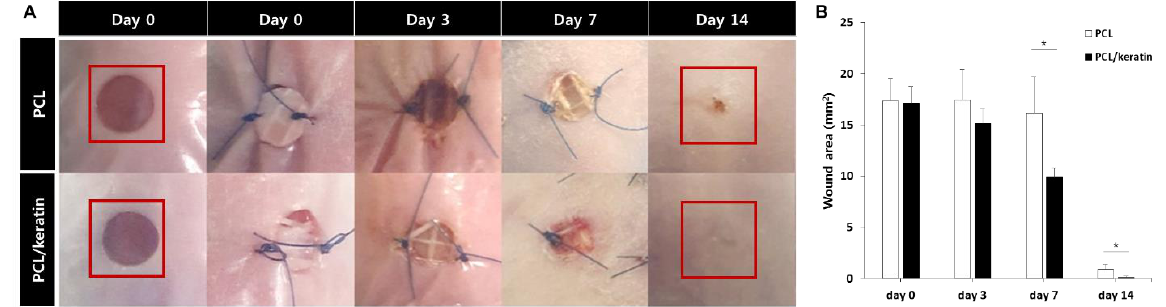
Figure 7. In vivo wound-healing results of PCL and PCL/keratin scaffolds. ( A ) Optical images of the wound areas of mice, and ( B ) analysis of the wound-healing performances using the PCL and PCL/keratin scaffolds (* p < 0.05).